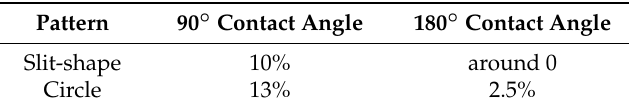
Table 2. The membrane area strain of circulating tumor cells (CTCs) trapped in the microfilters at an inlet velocity of 75 mm/s.